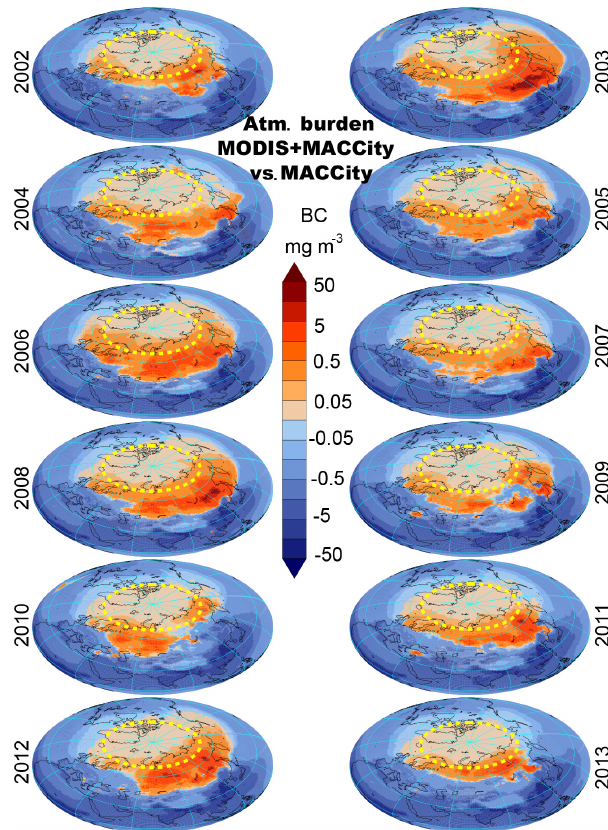
Figure 8. Difference in BC atmospheric burden (mgm − 3 ) be- tween our simulation that combines emission inventories (FEI- NE + MACCity) and MACCity. The dashed yellow line represents the limit of the Arctic ( ∼ 67 ◦ N). The BC burden was estimated by summing all the vertical layers and averaging with time (365 days) for each of the years between 2002 and